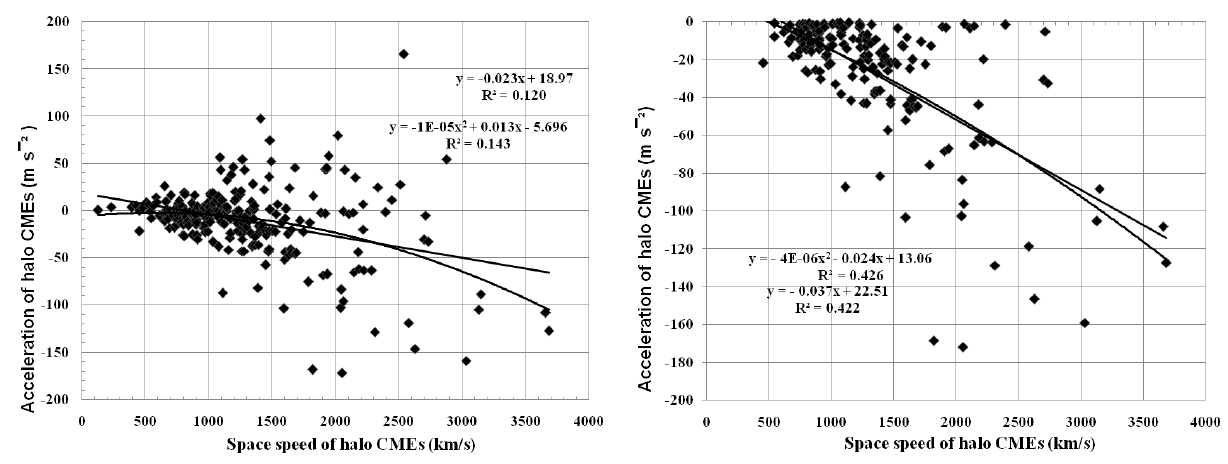
Figure 4. A plot of space speed of HCMEs (km/s) versus acceleration of the HCMEs (m/s 2 ).